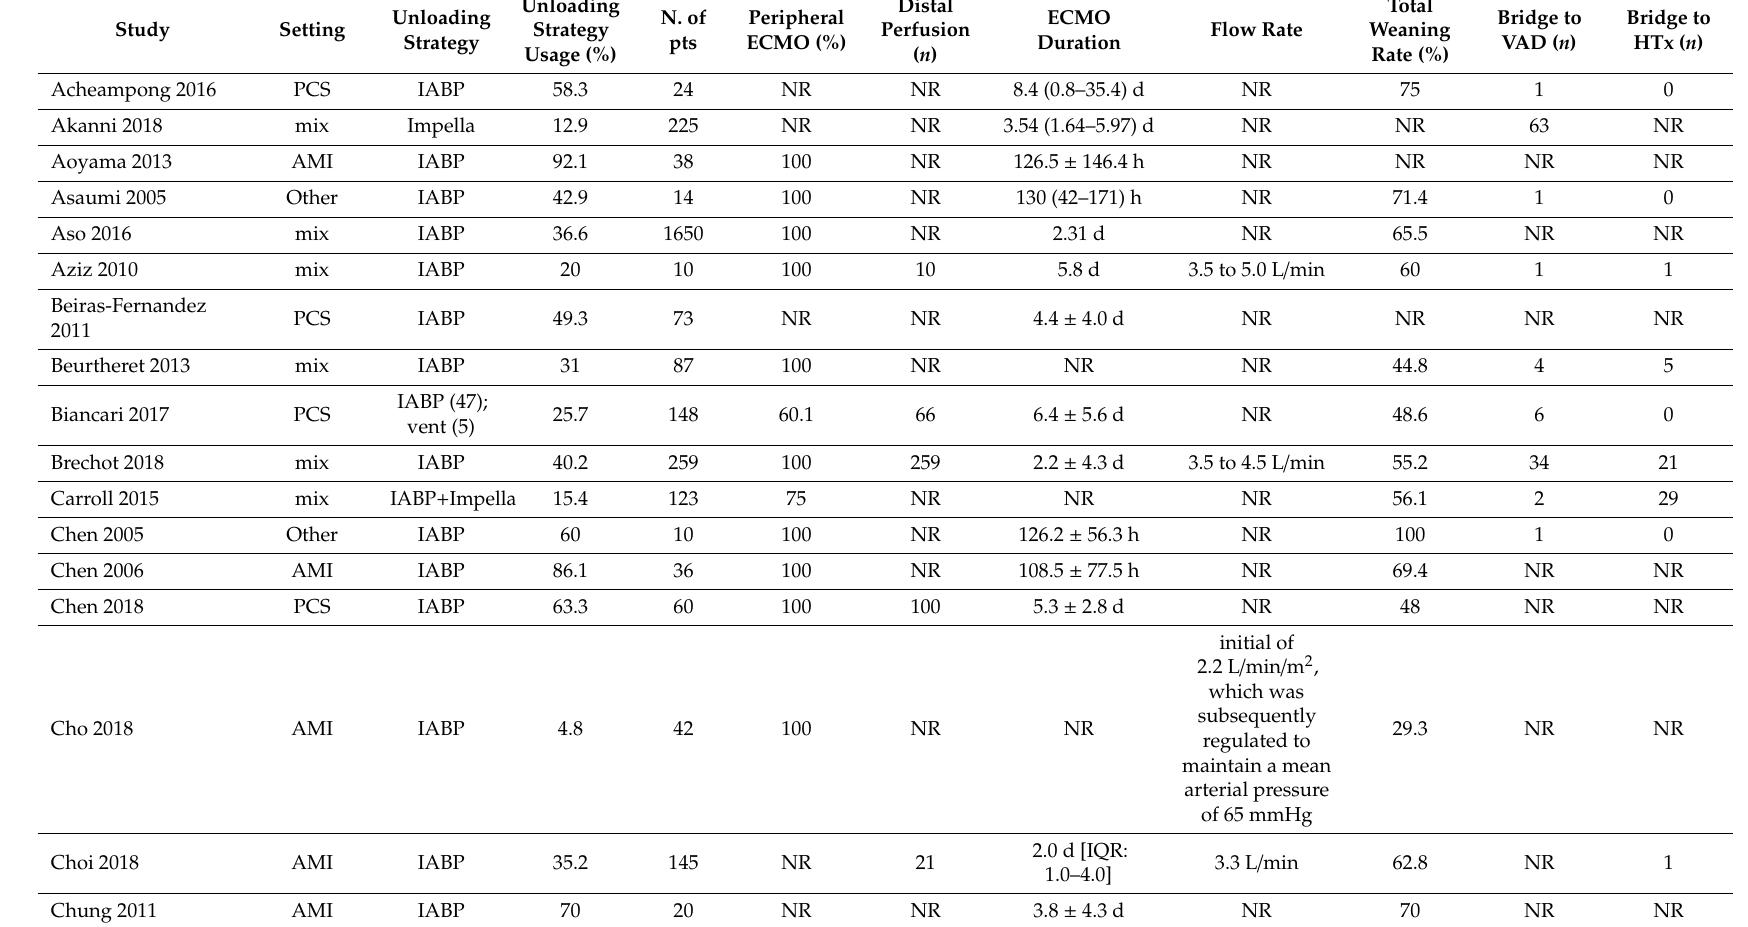
Table A2. Characteristics of included